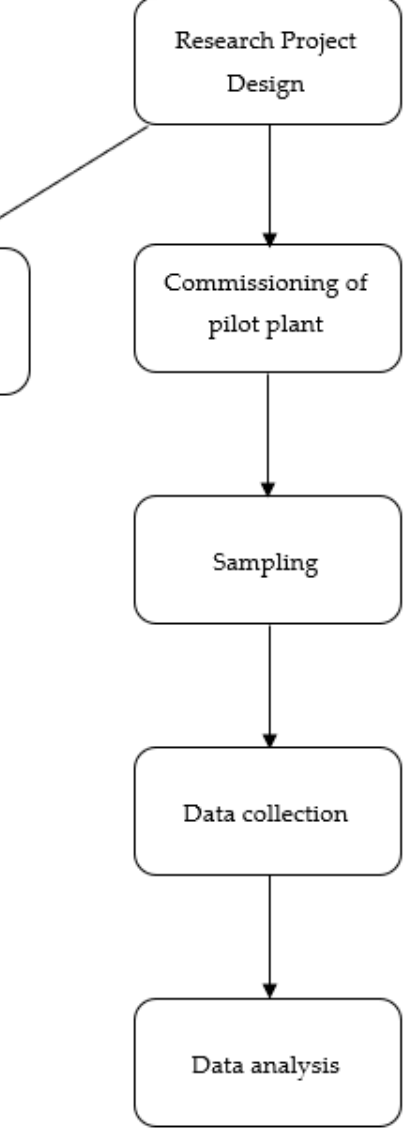
Figure 3. Graphical representation of the study.